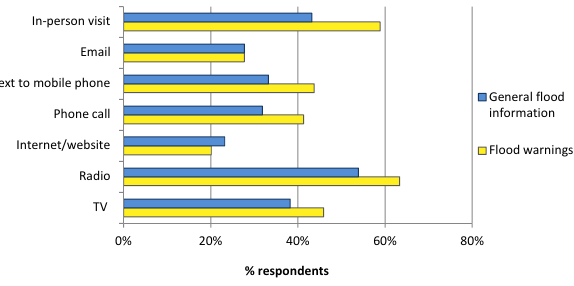
Fig. 5. Influence of understanding 1% AEP term on resilience levels in Finland ( n = 295; non response=30) and Italy ( n = 234; non- response=2).